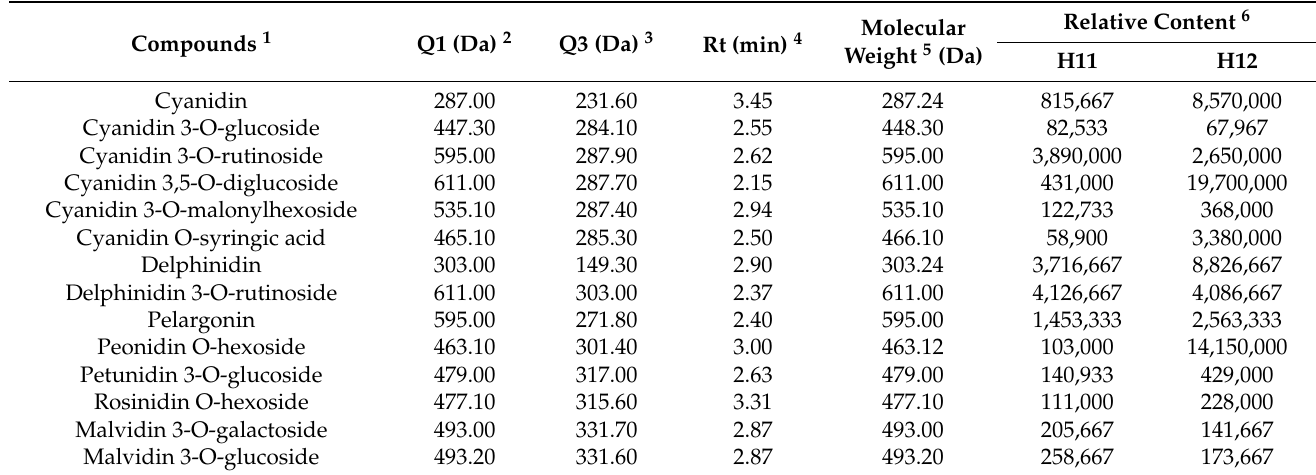
Table 1. List of anthocyanins and anthocyanidins detected in H11 and H12. Compounds